Question: How would you classify this visualization?
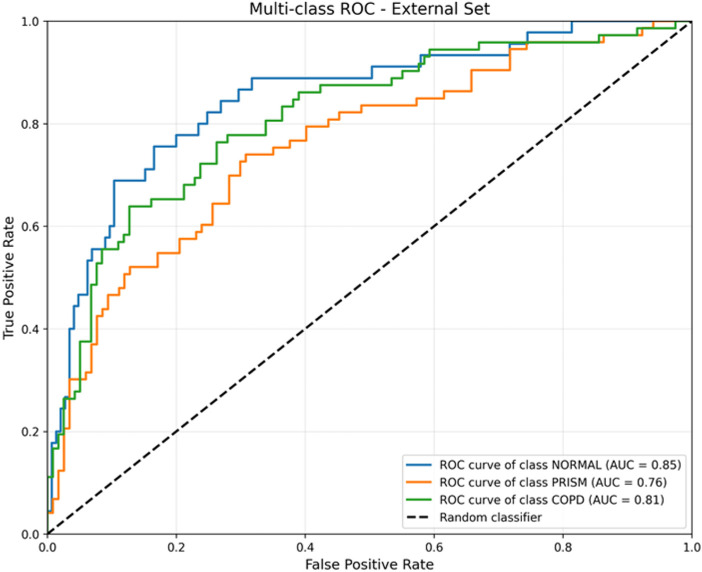
Answer: line